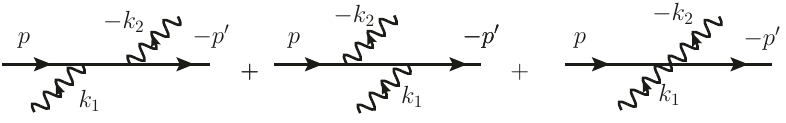
Figure 1 . Scalar QED like contributions to the Compton scattering in spinor QED. We use p, k 1 as incoming and − p 0 , − k as outgoing momenta. 2